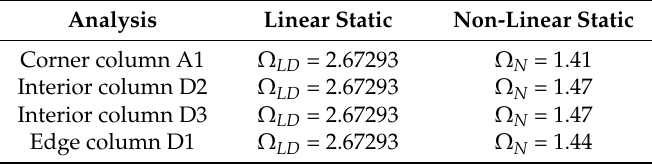
Table 4. Load increase factors for linear and non-linear static